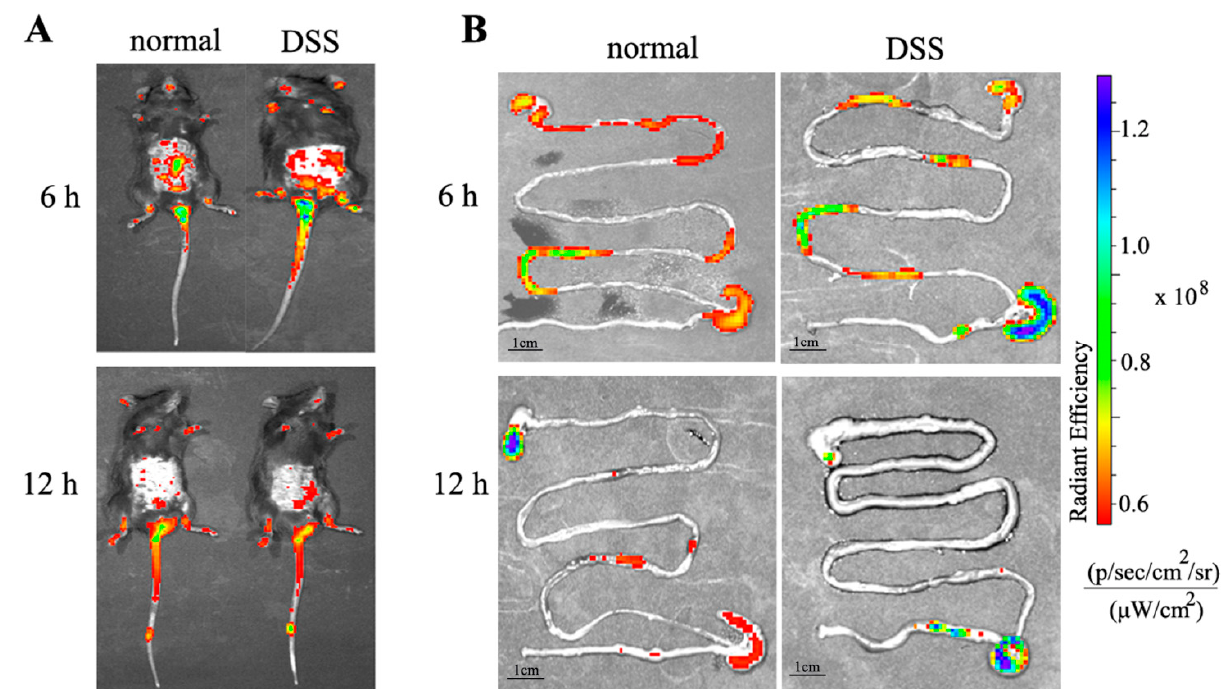
Figure 7. IVIS observes the fluorescence distribution in mice at 6 h and 12 h after oral administration of RES-PCAC-NPs ( A ). Near-infrared fluorescence images show the accumulation of NPs in the colon at different time points (6 h and 12 h) ( B ).